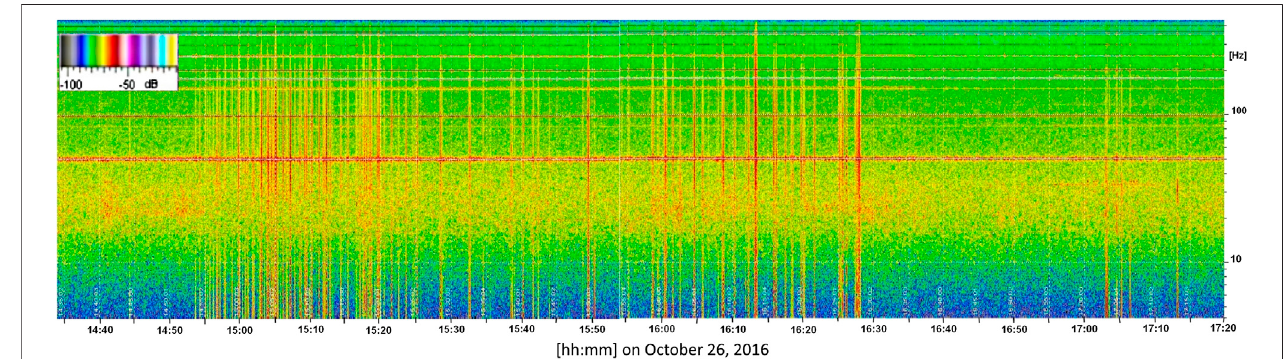
Frontiers in Earth Science |